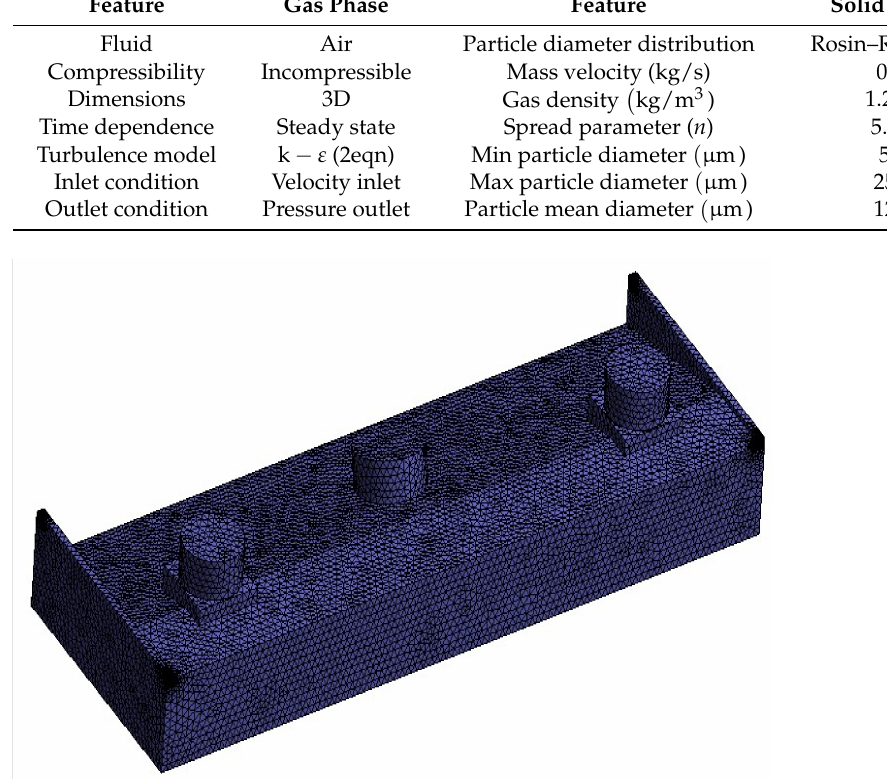
Figure 2. CFD surface mesh of the physical